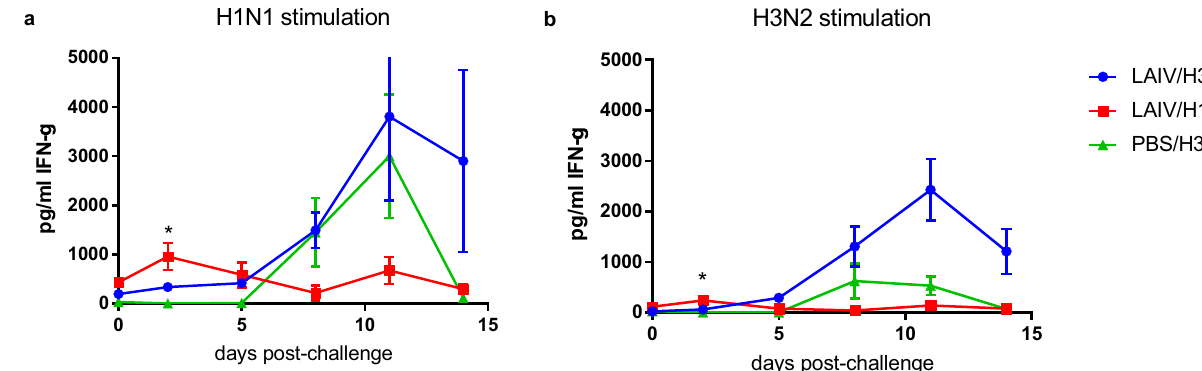
Fig. 7 Cellular immune responses to virus challenge in vaccinated and unvaccinated animals. IFN- γ response in antigen-stimulated whole blood was determined by ELISA. Blood was stimulated with wild-type a H1N1 or b H3N2 viruses. Points show mean and standard error. Samples taken 2 days before the challenge (equivalent to day 26 post-vaccination) are plotted as day 0. *Group LAIV/H1 day 2 values were signi fi cantly higher than the other two groups for both H1 stimulation ( a ; 1-way ANOVA with Tukey ’ s multiple comparisons test, P = 0.003, n = 6) and H3 stimulation ( b ; P = 0.006).